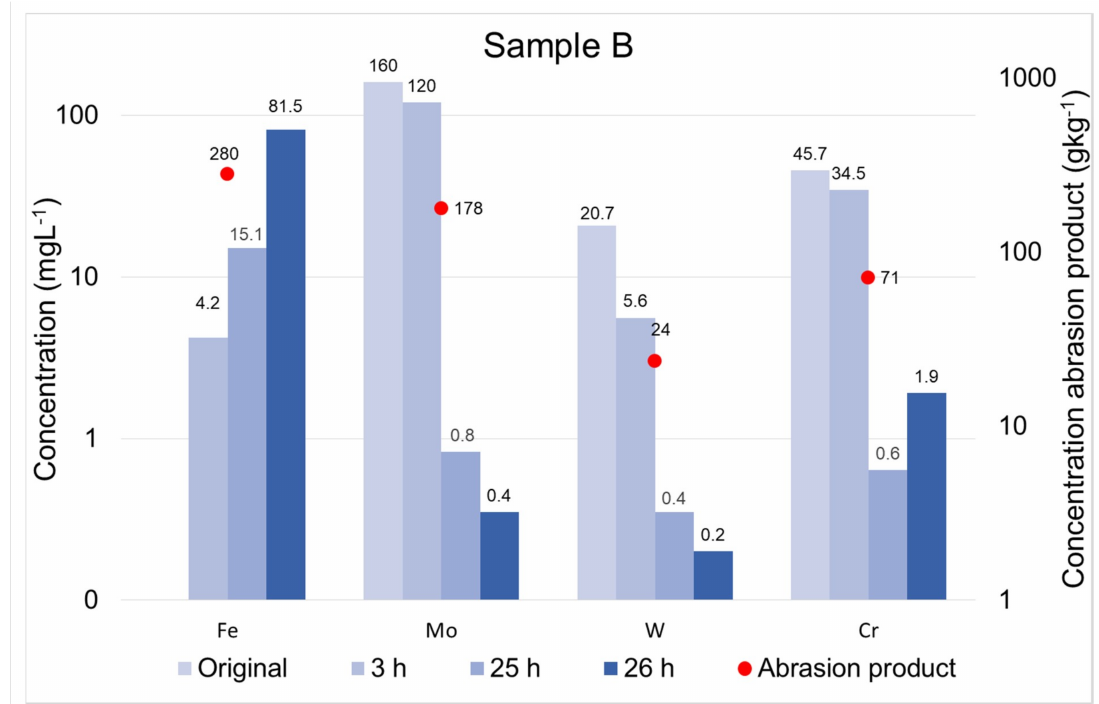
Figure 4. Evolution of the dissolved concentrations (blue bars) and concentrations in the resulting abrasion product (red dots) of Fe, Mo, W, and Cr during the Ferrodecont treatment of sample